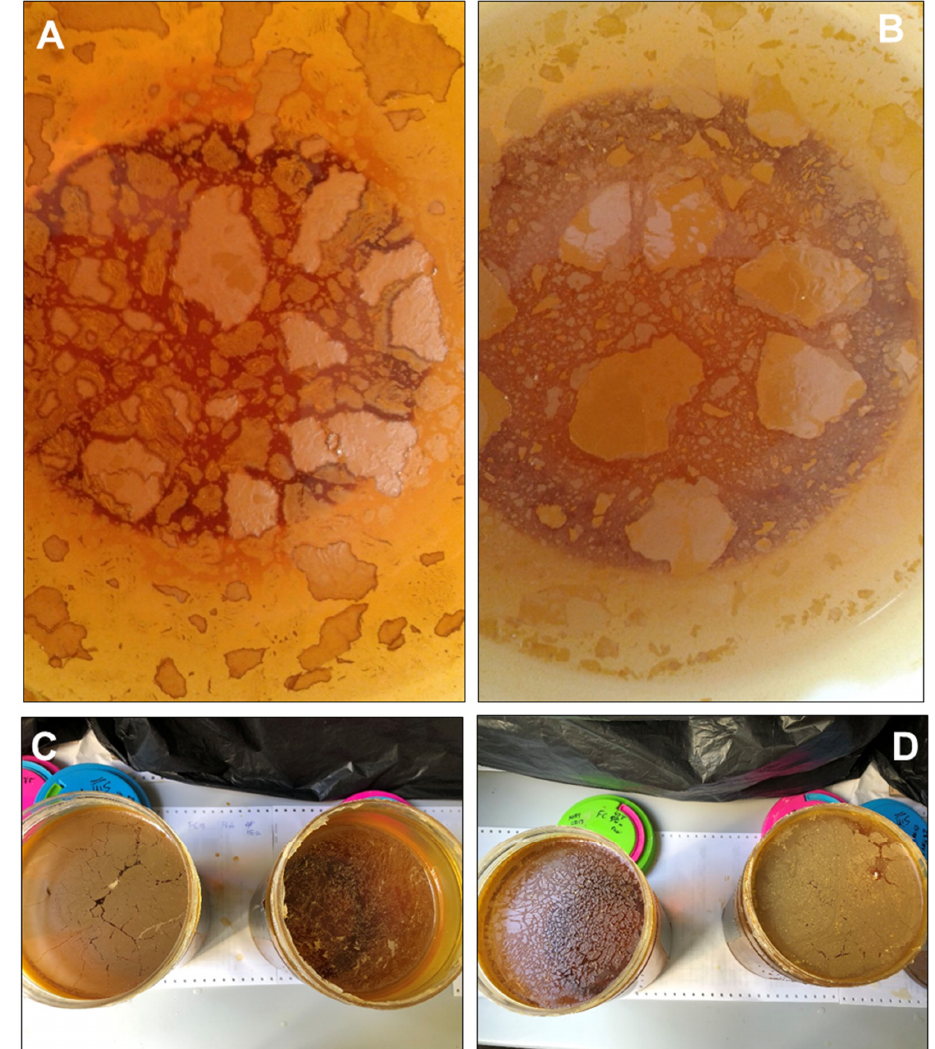
Figure 3. Floating mineral films formed on stagnant acidic mine water samples from the acidic Tintillo stream at pH 3.0 ( A ) and pH 2.2 ( B ) and from acidic pit lakes (Guadiana, C ; Filón Centro, D ) at pH 2.1. These samples were stored in glass flasks (14 cm in diameter) to assess the formation of floating mineral films under laboratory conditions; note the ocellated or breccia ‐ like textures observed in many of the flasks, in which the individual fragments exhibit lighter cores and darker rims (suggestive of different oxidation extent and/or degree of mineralization). The field of view in A ‐ B is 10 cm across. In these laboratory samples, it was also possible to observe “fossilized” bubbles due to the entrapment and subsequent iron mineralization of a gas phase (likely consisting of